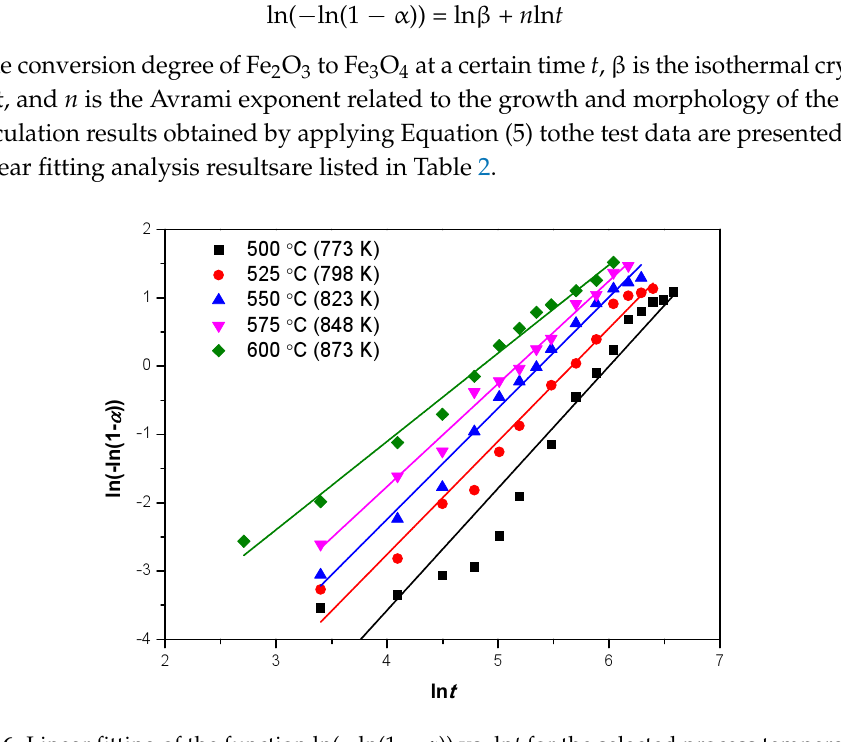
Figure 6. Linear fitting of the function ln( − ln(1 − α )) vs. ln t for the selected process temperatures.